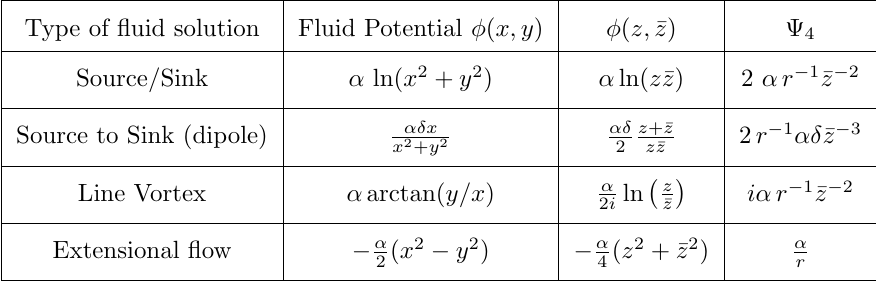
Table 1 . Some examples of standard (cid:13)uid solutions and the corresponding non-vanishing scalar (cid:9) 4 for type N solutions. For the dipole (cid:13)ow, (cid:14) refers to the distance between the source and the sink. Using (4.17), for this (cid:13)uid we